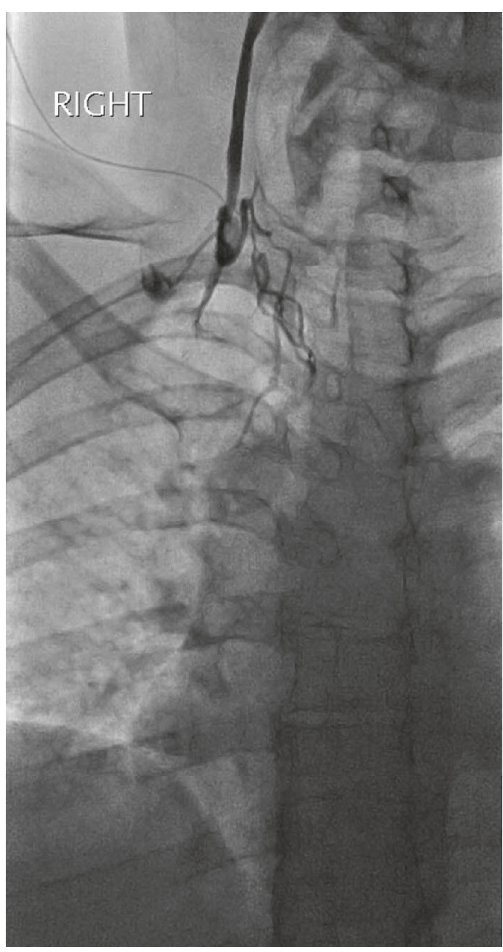
Figure 1: Right internaljugular venogram via micropunctureaccess revealing an occluded right internal jugular vein.